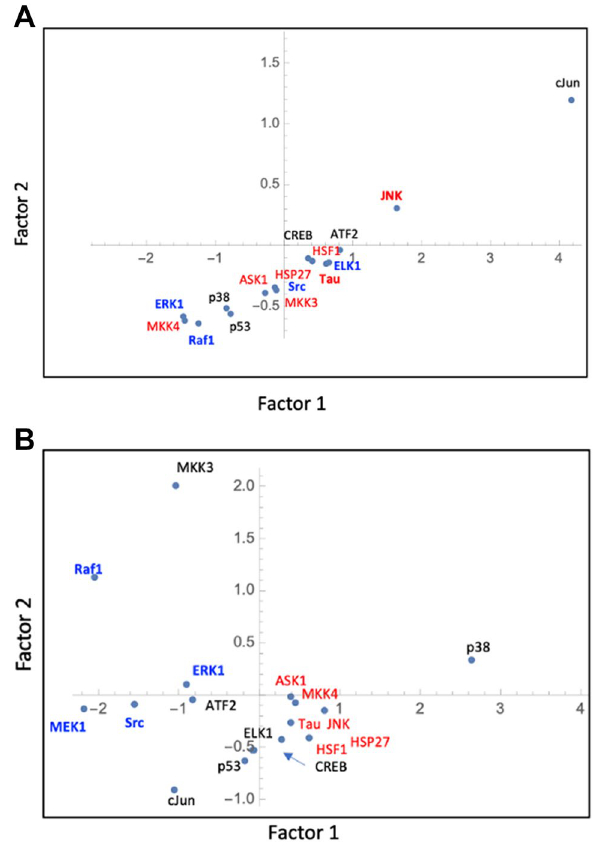
Figure 3. Dimension-reduction plot in the signal cascade in non-stressed ( A ) and stressed A431 cells ( B ). Blue letters represent the signal molecules in the SRME cascade, and MEK1 is out of the plot (− 2.73839, 3.19641) in ( A ). Red letters represent the signal molecules in stress-related